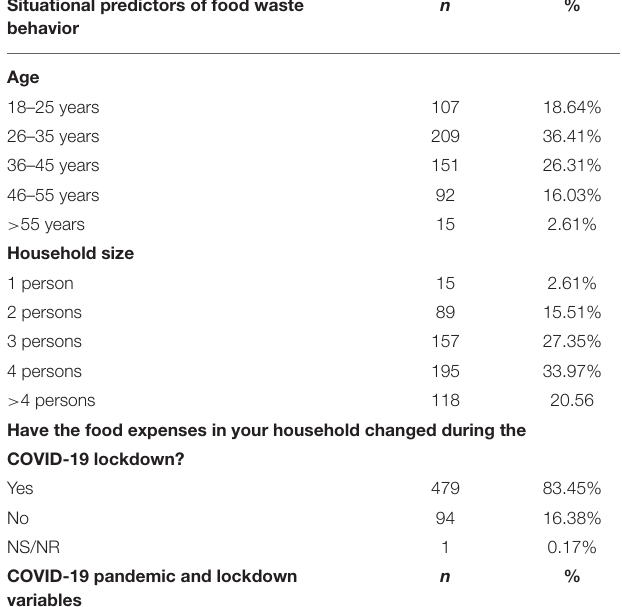
TABLE 2 | Summary statistics of the variables used for the analysis. Situational predictors of food waste